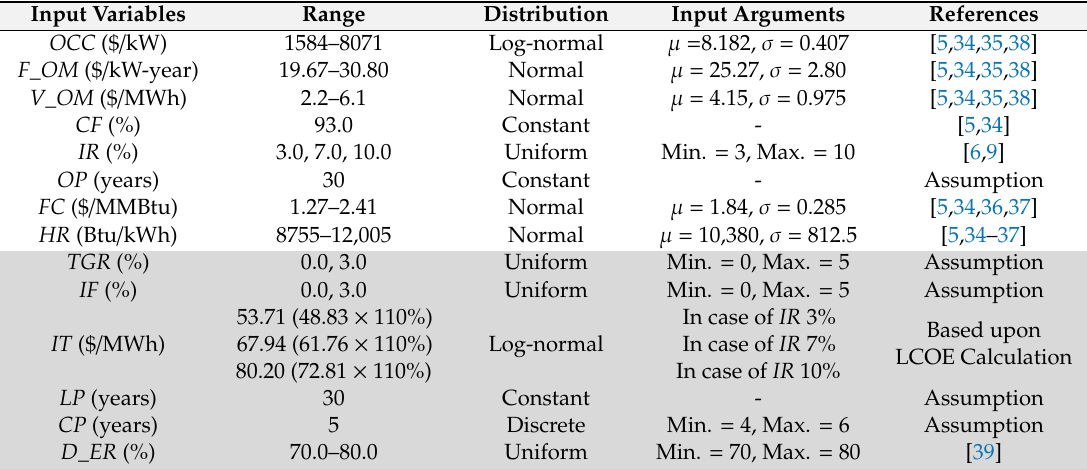
Table 1. Coal Input Variables.